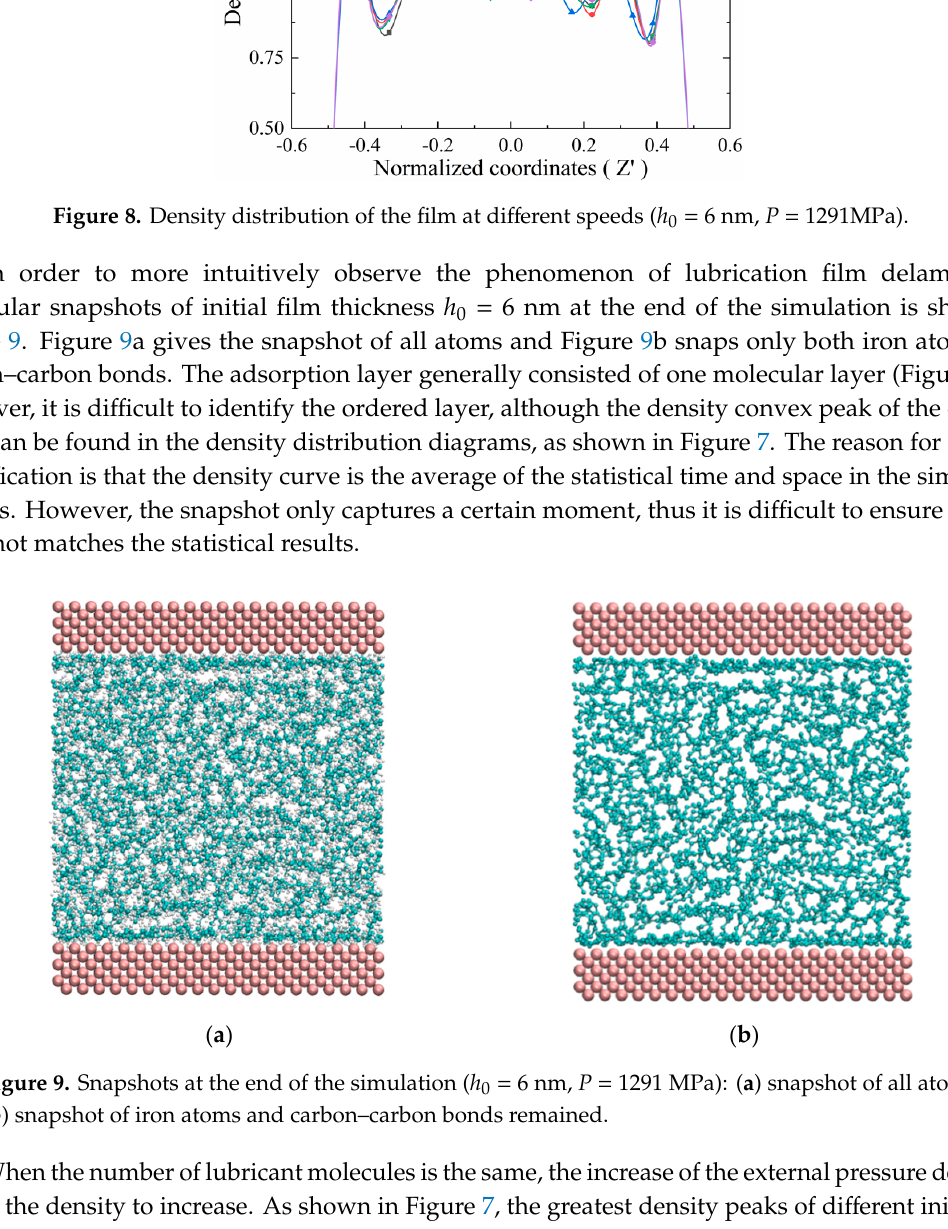
0 = 6 nm, P = 1291MPa).